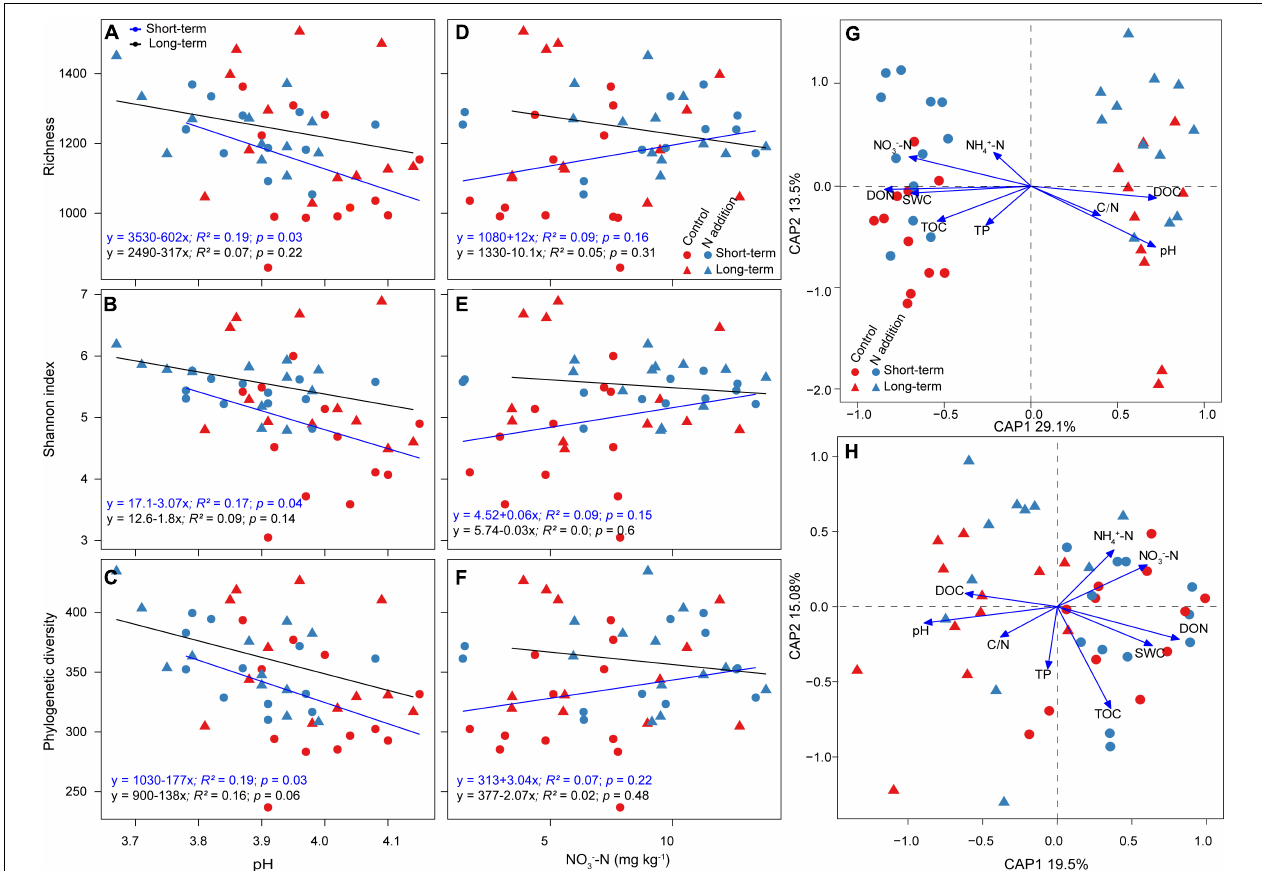
FIGURE 3 | Factors affecting fungal α -diversity and community composition. (A–F) Relationships between fungal α -diversity and soil pH and NO 3 - –N concentration are revealed by linear regression model. (G,H) CAP analysis shows the community dissimilarities based on Bray–Curtis distance and β MNTD against environmental variables among samples. SWC, soil water content (%); NH 4 + –N, ammonium N (mg kg – 1 ); NO 3 - –N, nitrate N (mg kg – 1 ); TOC, total organic carbon (%); TN, total N (%); C/N, total organic carbon/total N; TP, total phosphorus (%); DOC, dissolved organic carbon (mg kg – 1 ); DON, dissolved organic N (mg kg – 1